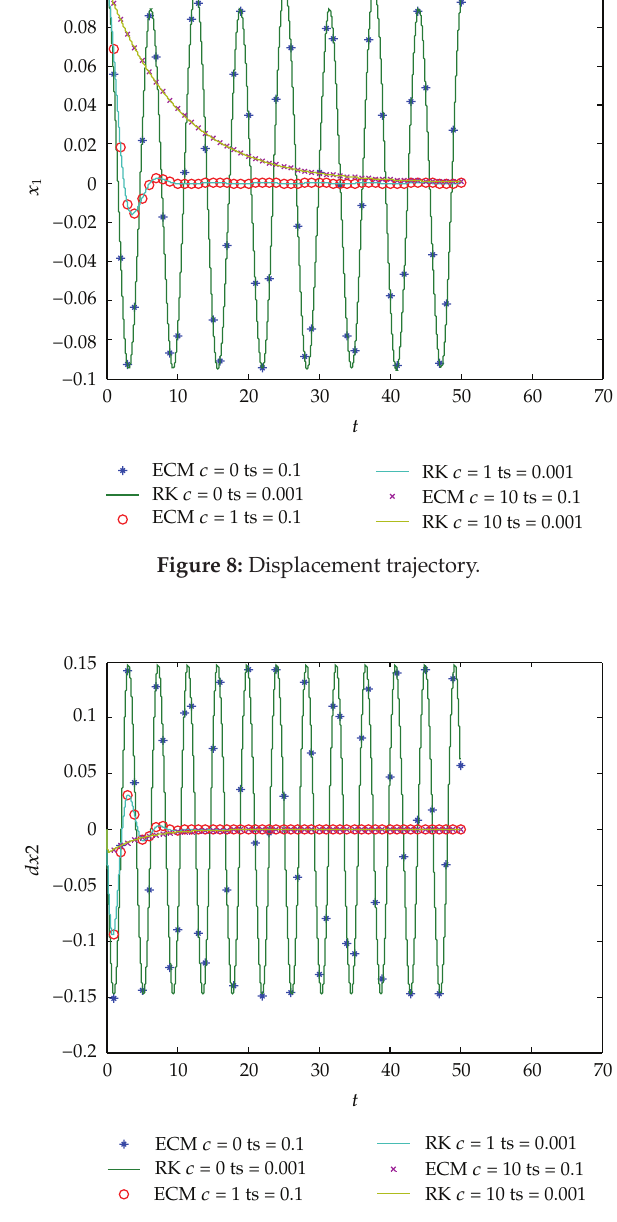
Figure 9: Velocity trajectory.